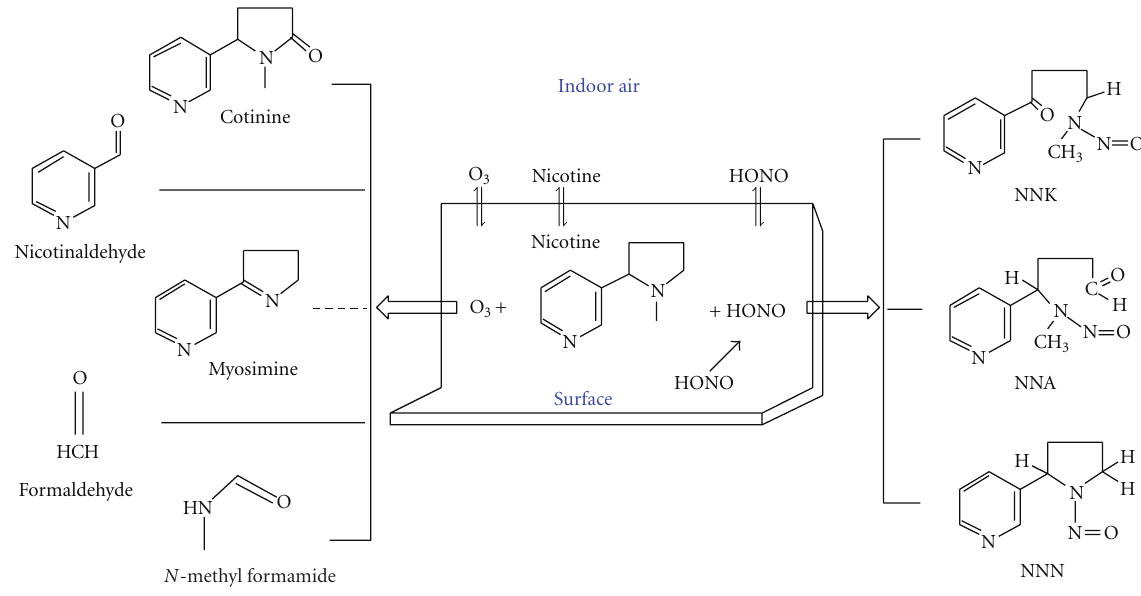
Figure 8: Stable nicotine-derived secondary products after reacting with ozone (O 3 ) or nitrous acid (HONO). All the structures illustrated were positively identified except for myosmine that was tentatively identified. HONO can be adsorbed from air source or derived from surface-catalyzed reaction. Adopted from the work by Destaillats et al. [317] and Sleiman et al.